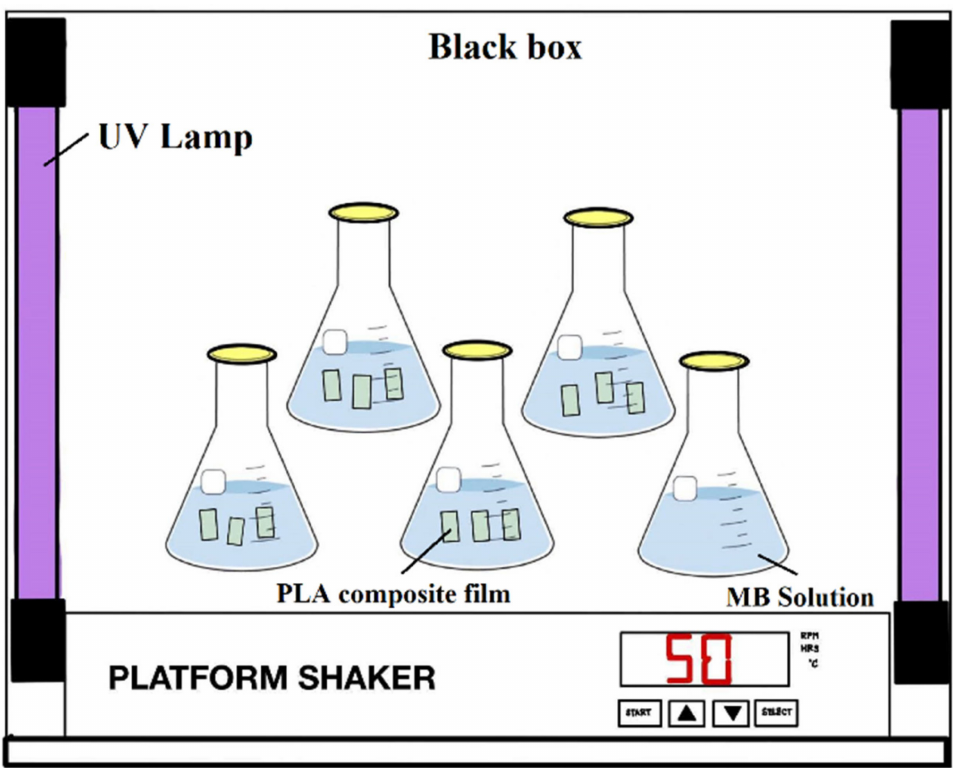
Figure 2. Schematic illustration of the experimental setup for photocatalytic process.